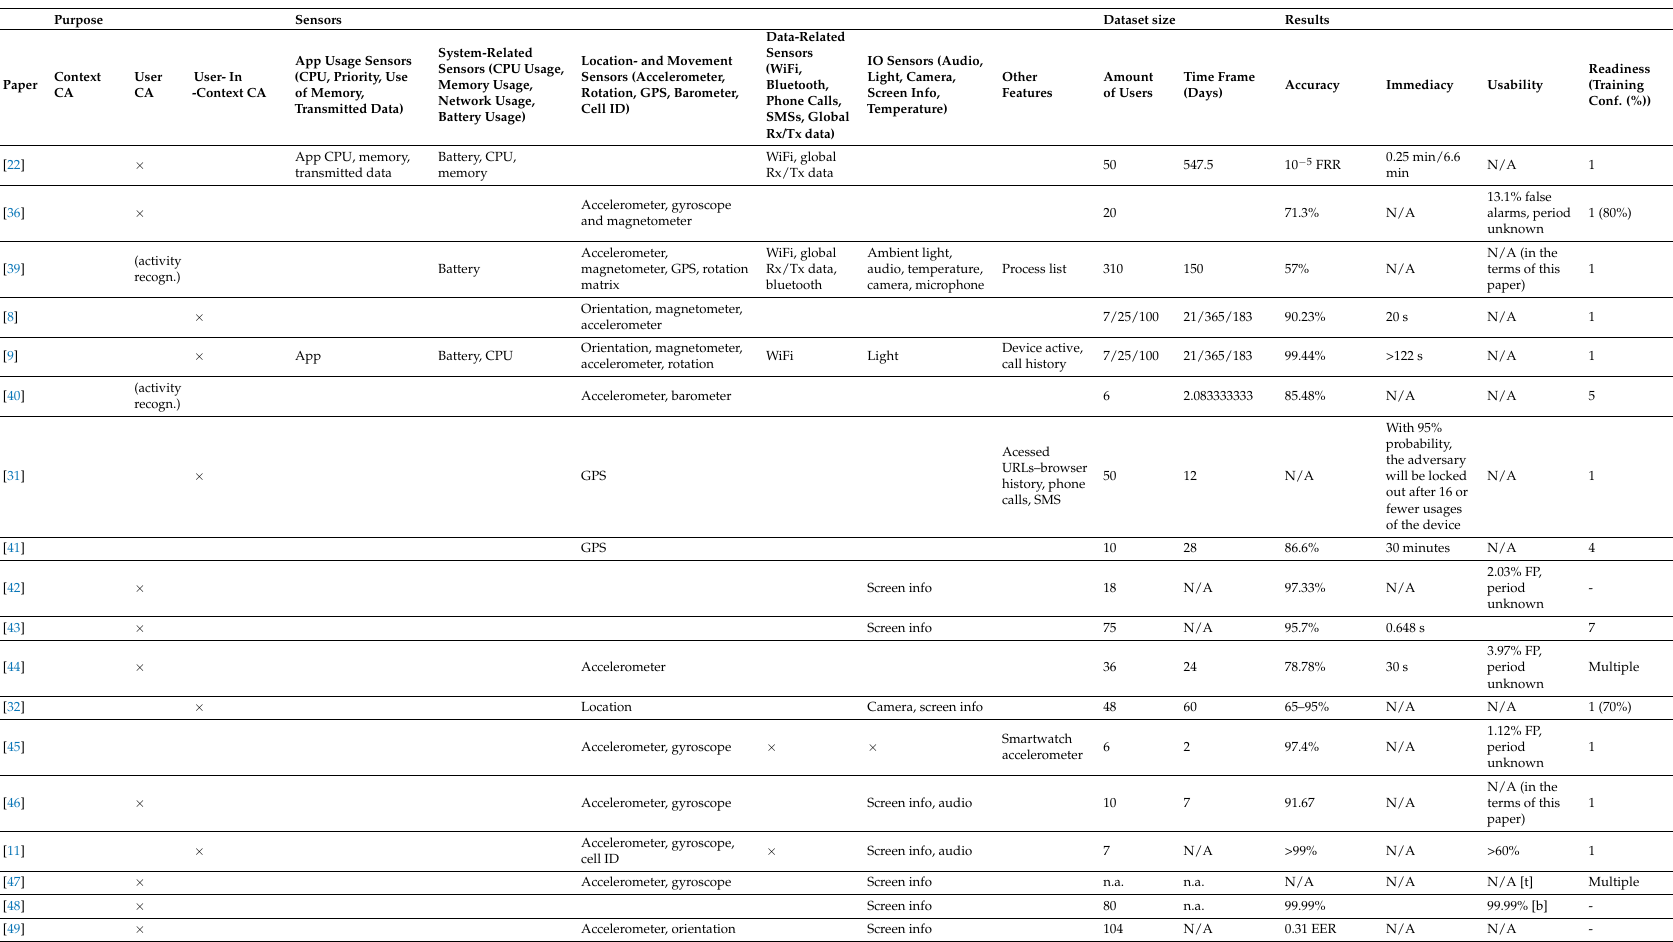
Table 6. Related work